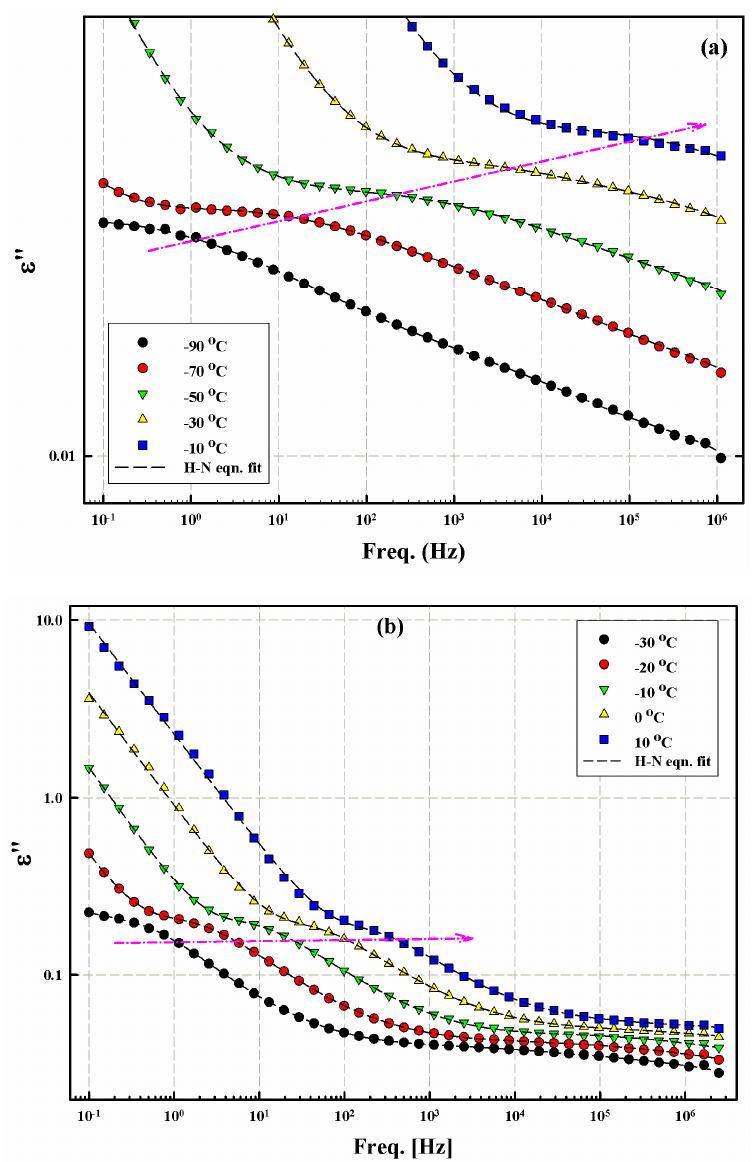
Figure 5. ε ′′ vs. f spectra of the control chitosan film in the low temperature range showing: Process I ( a ); and Process II ( b ). Dashed lines represent the H-N equation fits to the spectra. Arrows indicate the progress of the relaxation peak crests with increased temperature.